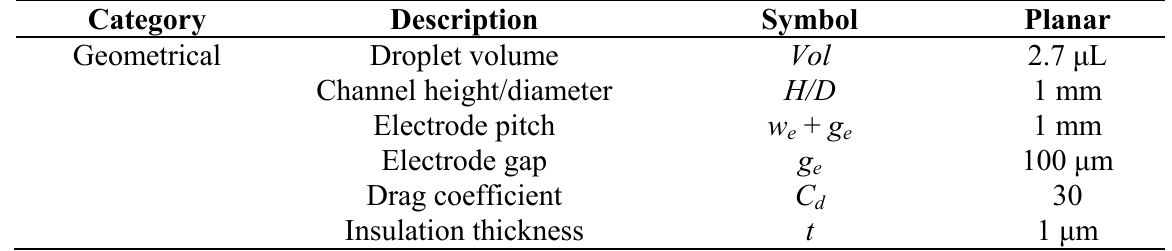
Table 1. Overview of the dynamic model parameters and the reference values used in the test